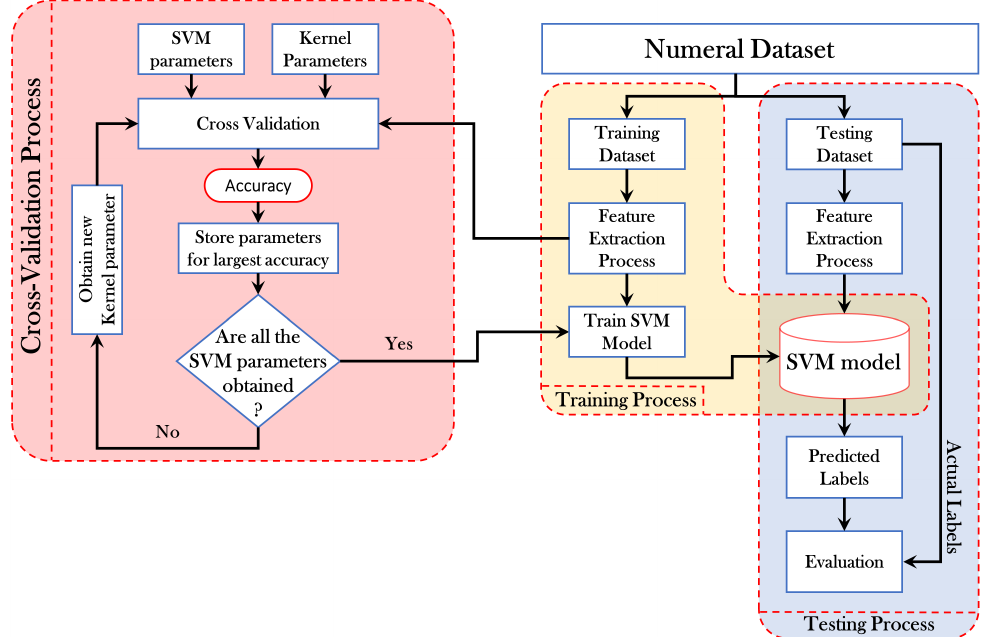
Figure 3. A schematic diagram for support vector machine (SVM) training and testing